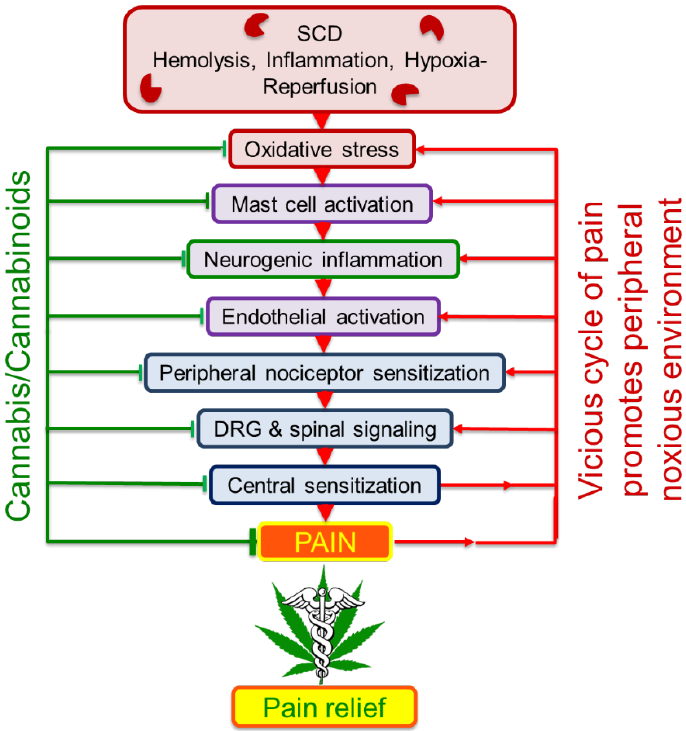
Figure 1. Cannabinoids ameliorate activation of peripheral and central mediators of sickle pain . In sickle cell disease ongoing hemolysis, inflammation, oxidative stress, mast cell activation, neurogenic inflammation, hypoxia / reperfusion injury and endothelial activation provide a noxious microenvironment that leads to nociceptor activation in the periphery as well as the central nervous system (CNS). Continued neuronal activation in the dorsal root ganglia leads to the amplification and transmission of action potentials to the spinal second order neurons causing hypersensitization resulting in central sensitization and pain refractory to treatment. Continued sensitization causes an antidromic release of substances from the CNS to the periphery causing neuroinflammation, which in turn lead to sensitization of peripheral nerve fibers and transmission of action potentials, thus leading to a vicious cycle of peripheral and central sensitization and pain. Cananbinoids have the potential to inhibit oxidative stress, inflammation, neuroinflammation and peripheral / central sensitization, thereby ameliorating the underlying pathobiology of sickle cell disease that may initiate pain and also by directly inhibiting the neuronal activity, leading to amelioration of pain.